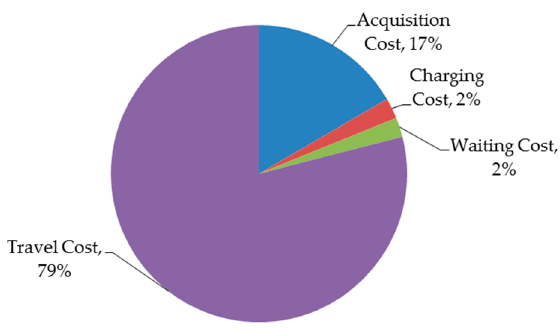
Figure 3. Percentages of costs of the best solution of R1.